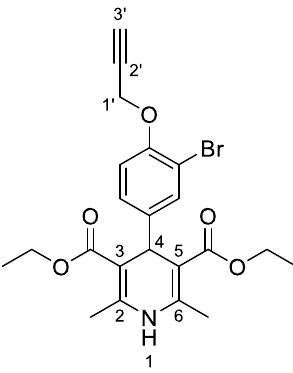
Figure 11. Chemical stucture of 3j .